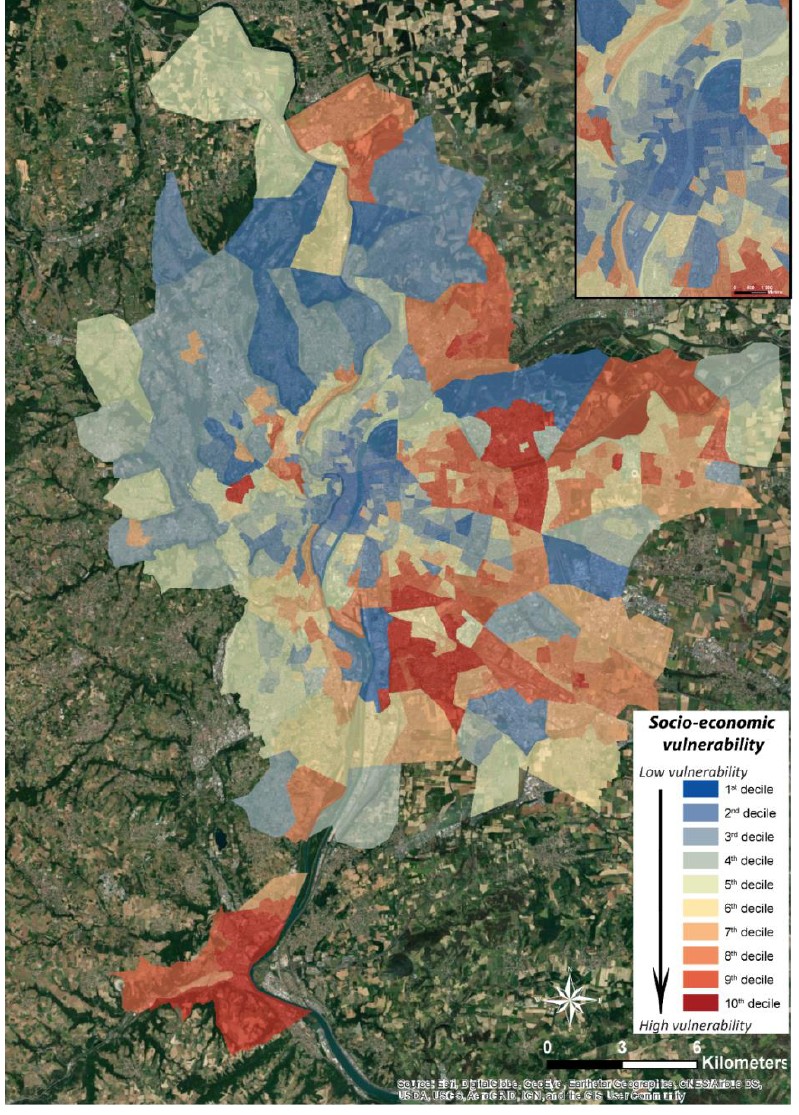
Figure 6. Spatial representation of the socio-economic vulnerability of Lyon’s population to heat waves—(discretization by deciles)—zoom on the center of Lyon in top